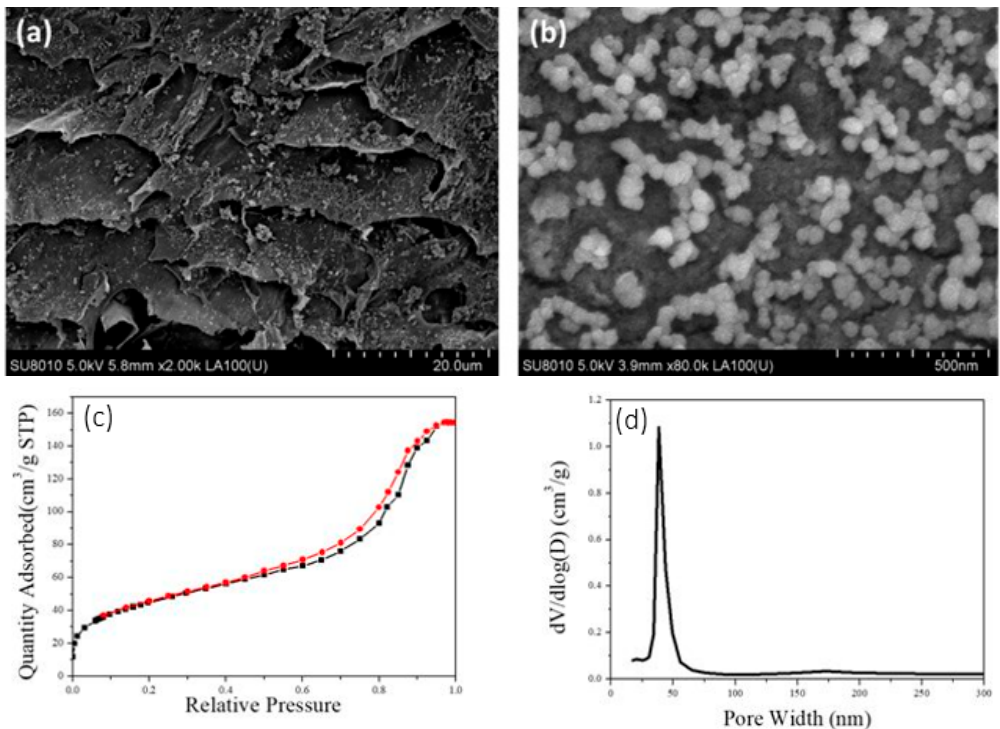
Figure 6. ( a ) and ( b ) The SEM image of TiO2@CNF Aerogel in different resolution, ( c ) N 2 adsorption–desorption isotherm, and ( d ) pore size distribution of TiO2@CNF Aerogel.